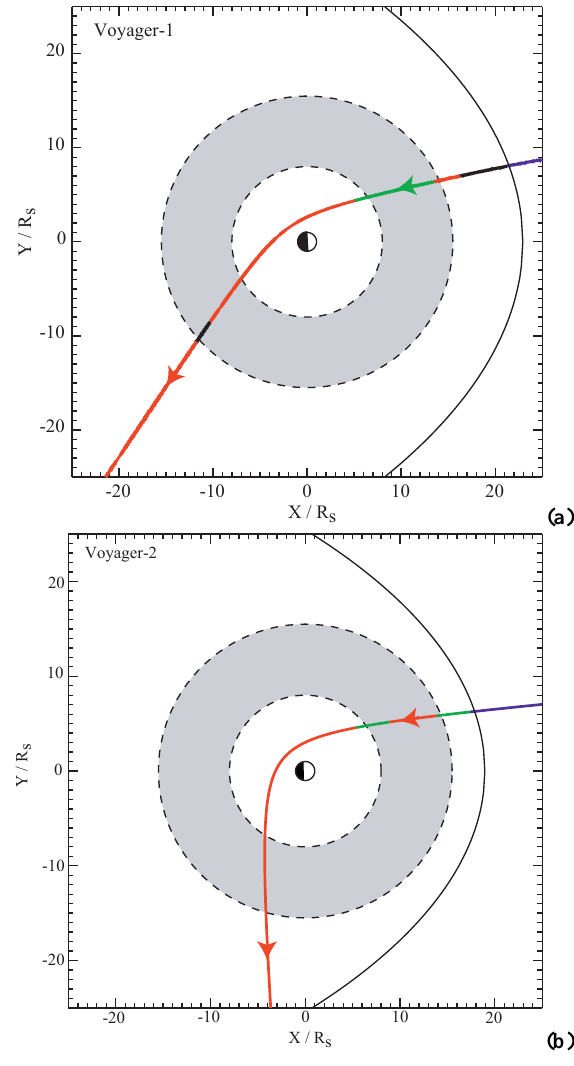
Fig. 3. Plots showing the colour-coded trajectories of (a) Voyager-1 and (b) Voyager-2, projected onto Saturn’s equatorial plane, where X points towards the Sun and Y from dawn to dusk. The trajectories are colour-coded red when the observed azimuthal field is consis- tent with a ‘lagging’ field configuration (ignoring rapid fluctuations in the field), green when it is consistent with a ‘leading’ field con- figuration, and black when the azimuthal field is near-zero for an extended interval. The trajectories are colour-coded blue when the spacecraft is in the inbound magnetosheath. The black solid lines show model magnetopauses fitted to the observed magnetopause en- counter(s) (the centre position of the five inbound magnetopauses in the case of Voyager-1), where we have employed the same magne- topause shape as used in the Tsyganenko field model. The stippled areas bounded by the dashed circles indicate the region of the Con- nerney et al. (1983) model ring